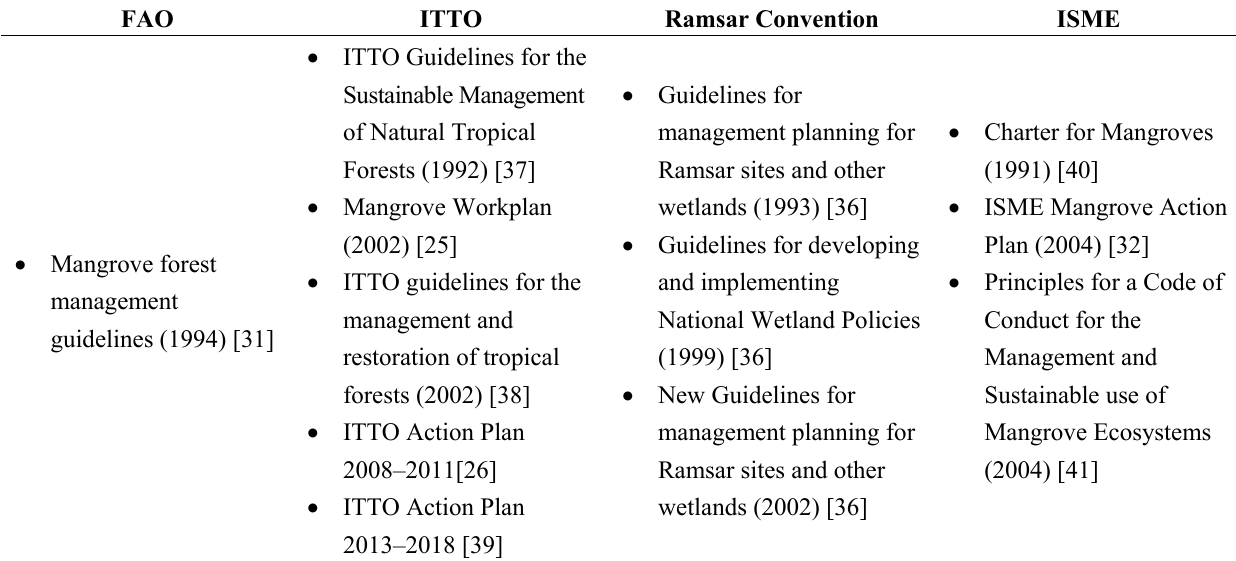
Table 2. Primary management guideline documents for mangrove ecosystems. FAO